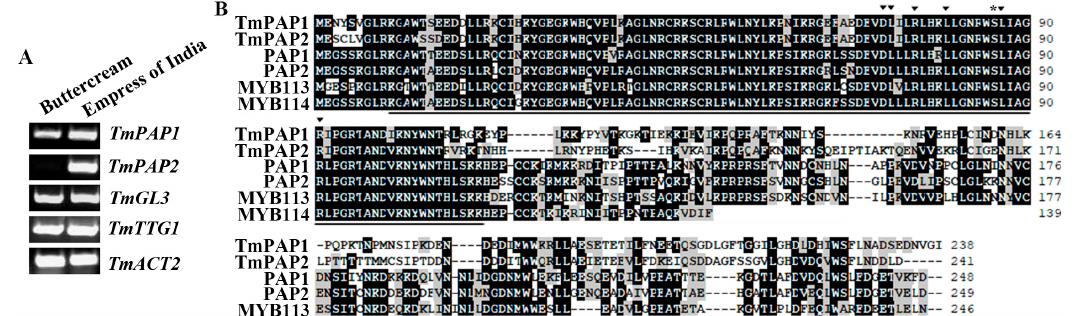
Figure 2. Nasturtium homologs of the Arabidopsis MBW complex proteins . ( A ) Phylogenetic analysis of anthocyanin biosynthesis-regulating R2R3 MYB transcription factor in Arabidopsis and their homologs in nasturtiums . ( B ) Phylogenetic analysis of the anthocyanin biosynthesis-regulating bHLH transcription factors in Arabidopsis and their homologs in nasturtium plants . ( C ) Phylogenetic analysis of the anthocyanin biosynthesis-regulating WD40 transcription factor in Arabidopsis and its homologs in nasturtiums . The amino acid sequences of Arabidopsis proteins were obtained via Phytozome (https://phytozome-next.jgi.doe.gov, accessed on 1 May 2021), while the amino acid sequences of nasturtium proteins obtained in this study are listed in File S1 in the Supplementary Materials. Phylogenetic analysis was performed on Phylogeny (http://www.phylogeny.fr/simple_phylogeny.cgi, accessed on 1 August 2022).